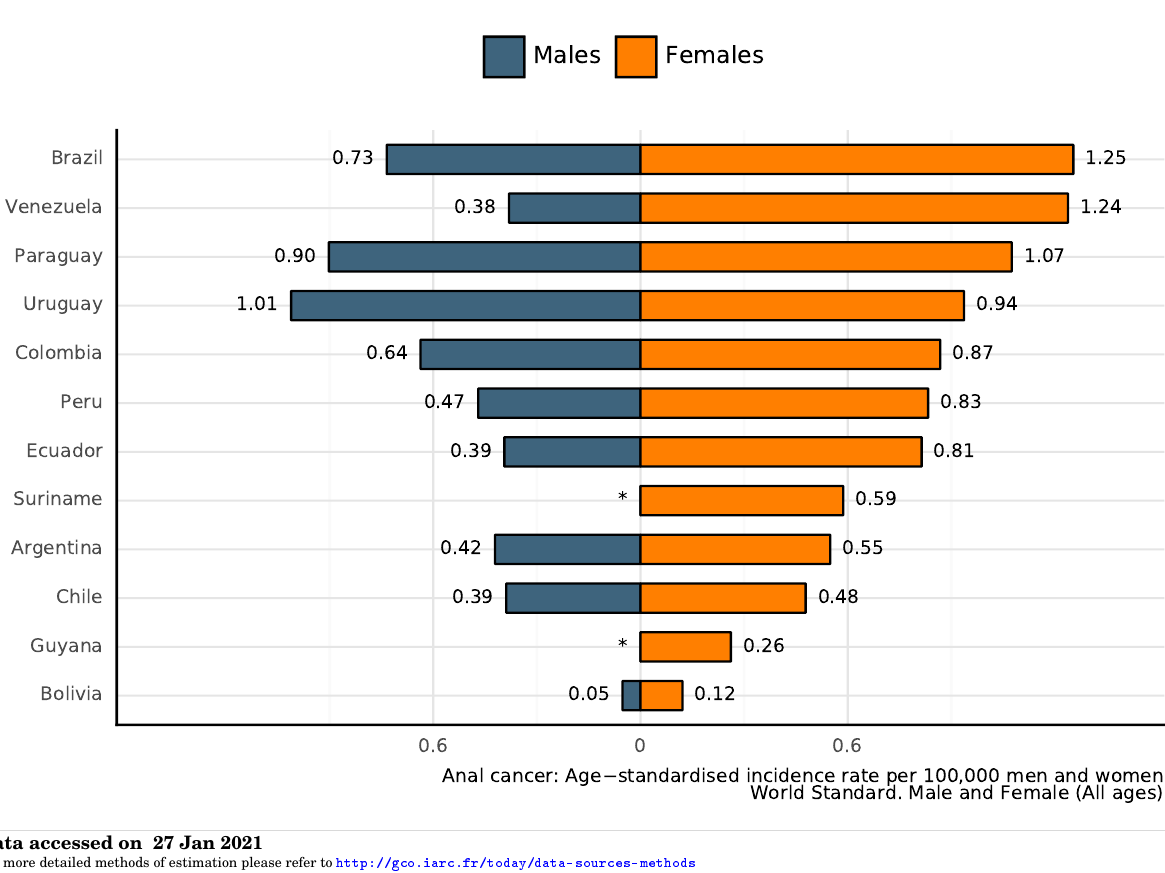
Figure 76: Age-standardised incidence rates of anal cancer of Peru (estimates for 2020)